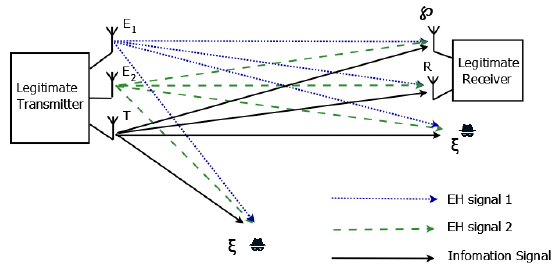
Figure 1. System model. EH, energy harvesting.